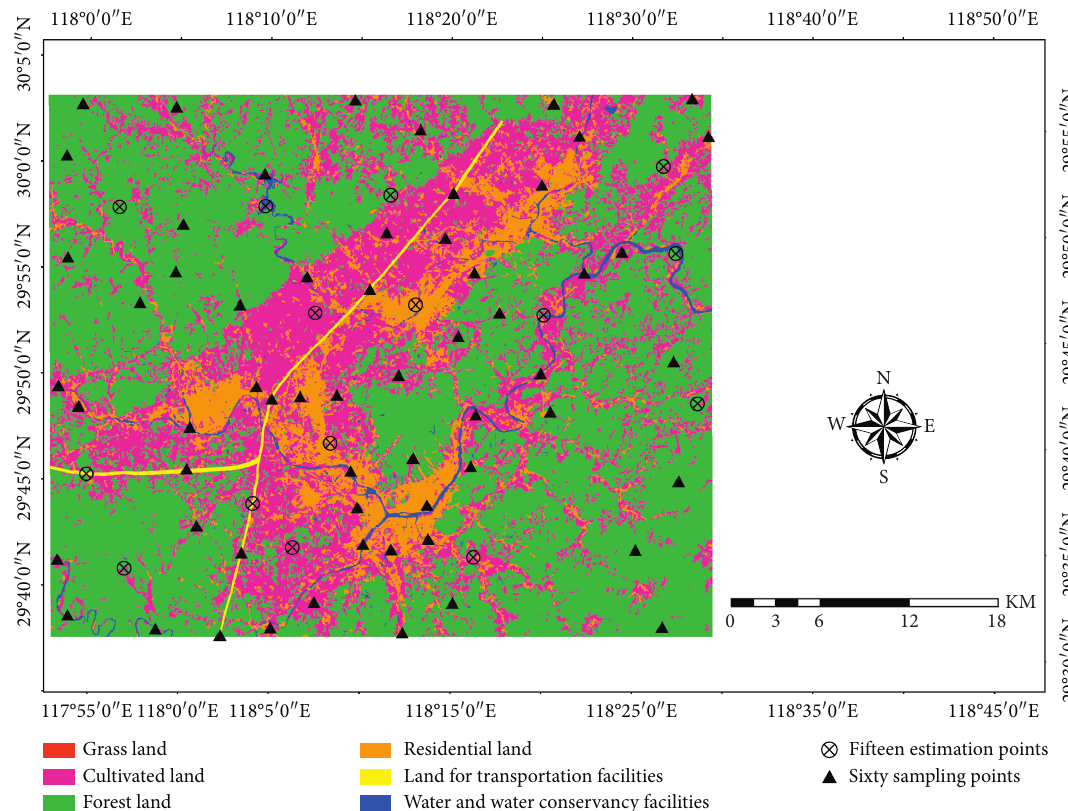
Figure 4: Distribution map of discrete points and pending valuation points in study area-2. Table 12: Comparison of interpolation results of 5 kinds of interpolation methods on Feb. 11, 2017. Forecast date: Feb. 11, Study area-2